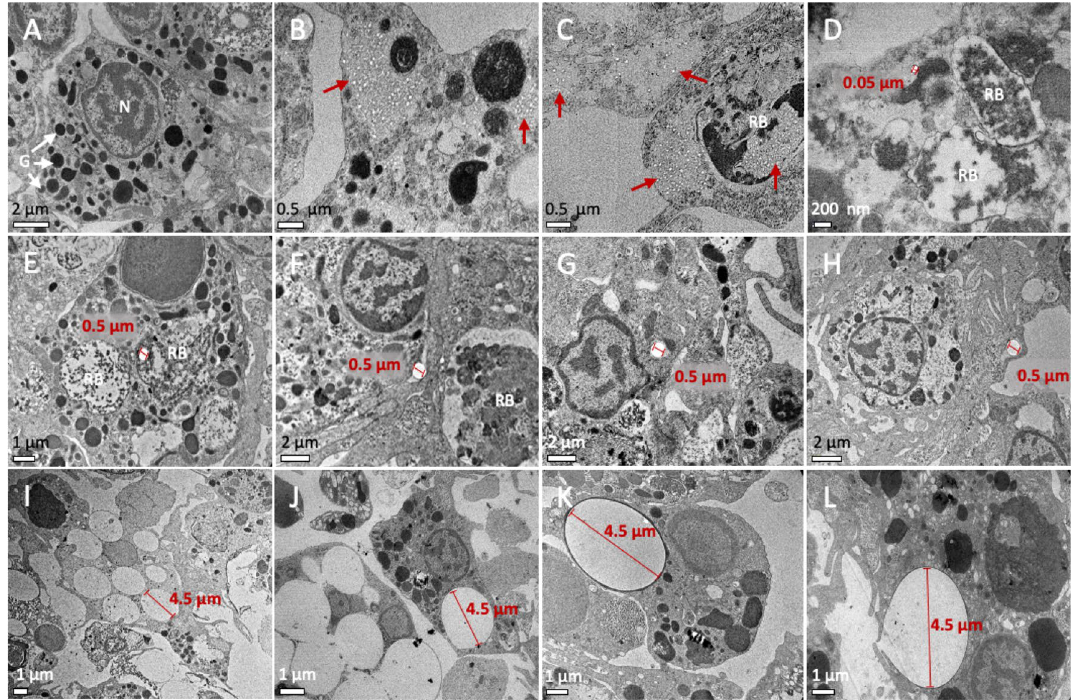
Figure 1. TEM images showing the intracellular localization of NPs and MPs in mussel hemocytes. ( A ) control cells, ( B – D ) hemocytes treated with 10 12 part./mL of 0.05 μm NPs, ( E – H ) hemocytes treated with 10 9 part./ mL of 0.5 μm MPs and ( I – L ) hemocytes treated with 10 8 part./mL of 4.5 μm MPs. Red arrows indicate the intracellular localization of NPs at low power magnification. Size of selected NPs and MPs is indicated (red lines). N, nucleus; G, granules; RB, residual